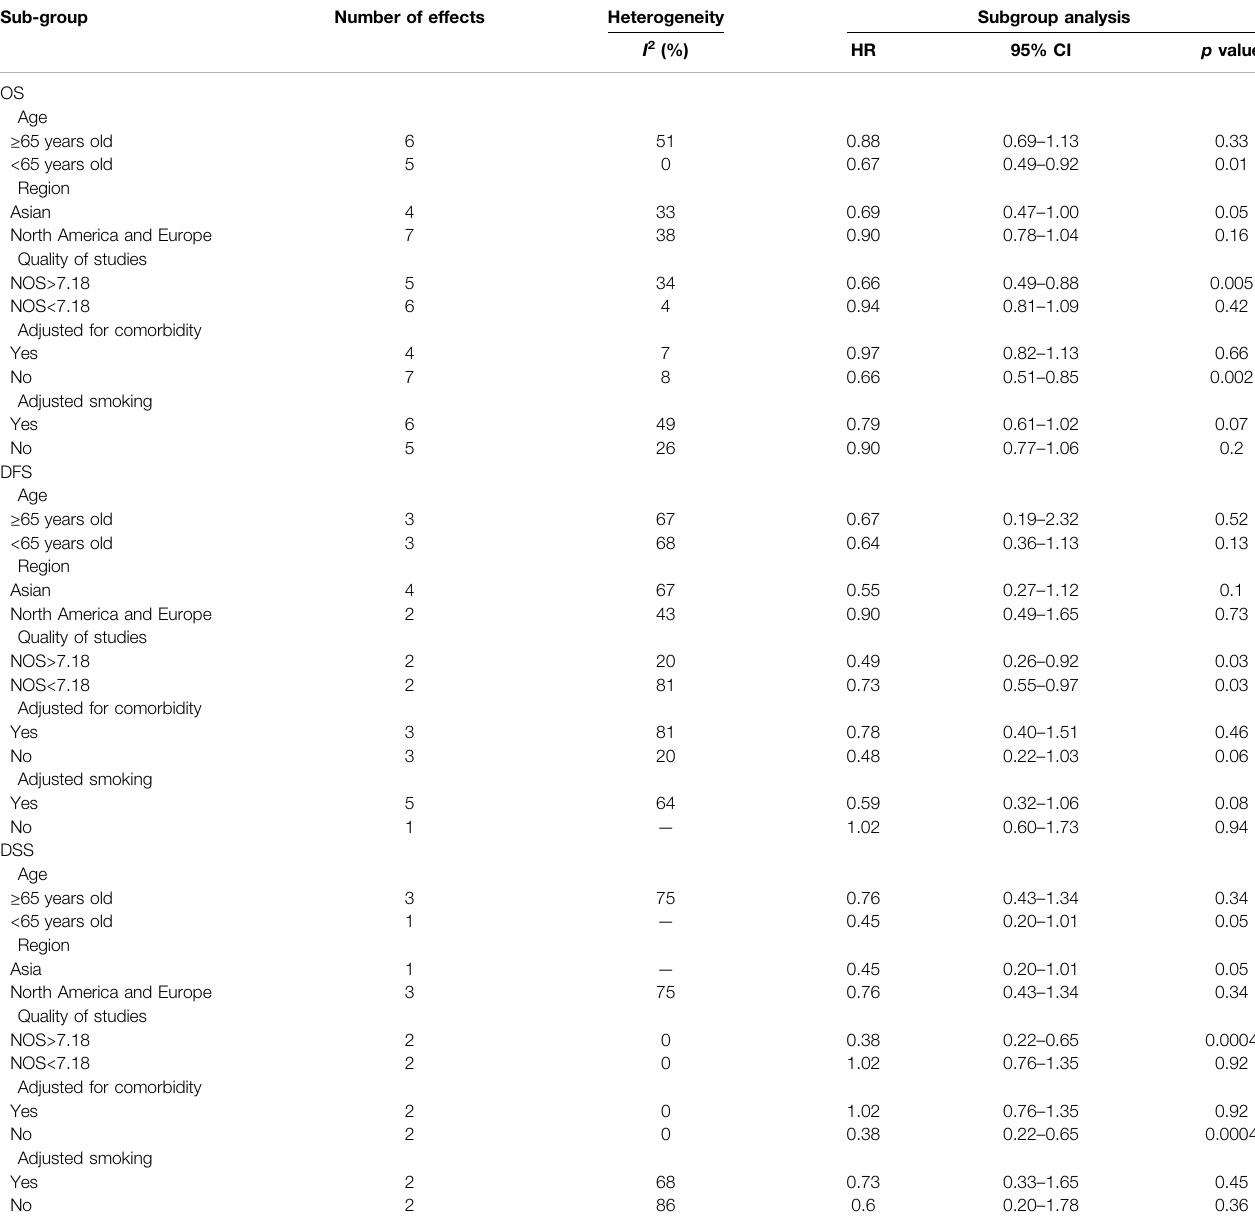
TABLE 3 | Results of subgroup